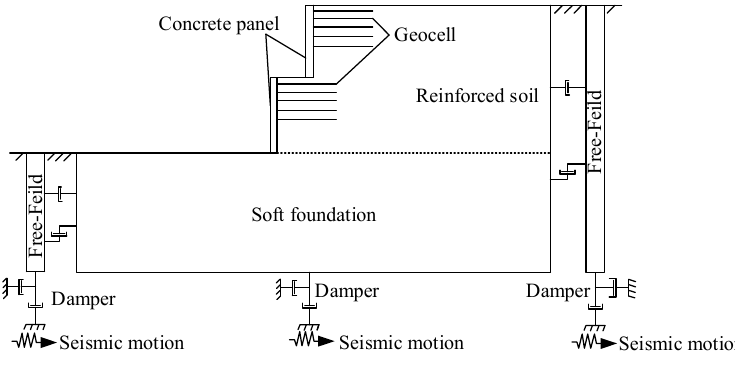
Figure 6. Seismic input.